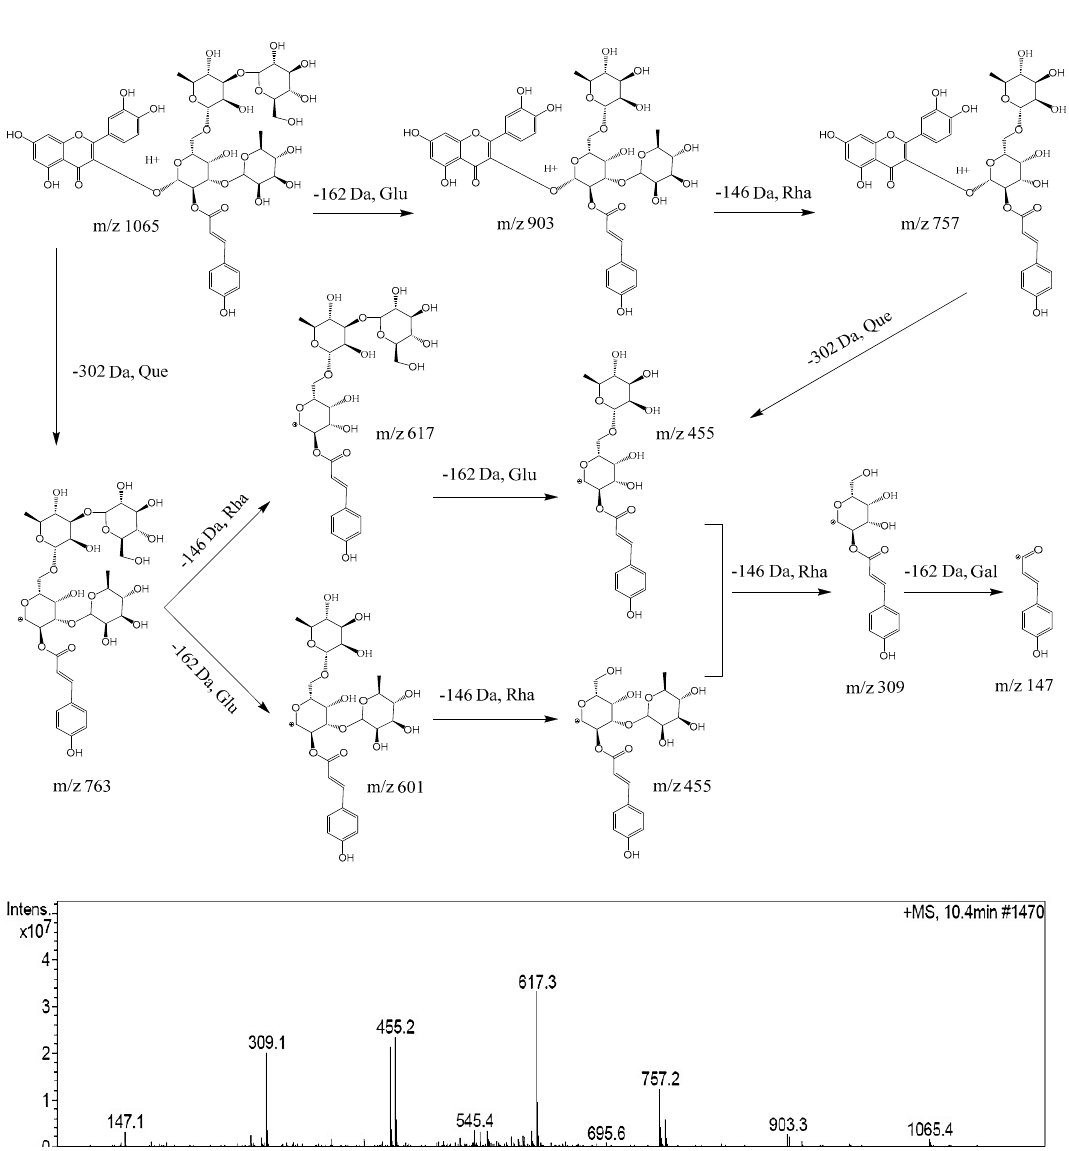
Figure 2. Proposed fragmentation pathway of camelliquercetiside E in positive ion mode.